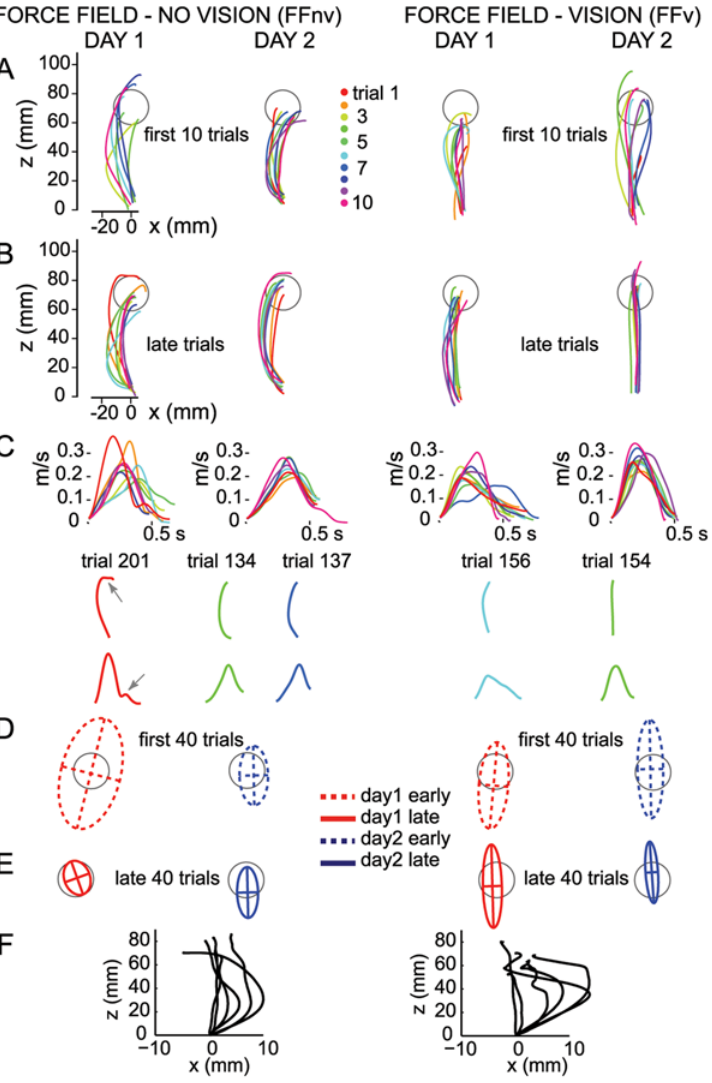
Figure 2. Adaptation to force fields with and without visual feedback: Single subjects. A–B, Day1 and day2 hand paths of two single subjects during the first 10 trials and late trials (ranging from trial 131–220) of force field without visual feedback (FFnv, left) and with (FFv, right). Aborted trials (see methods) are not shown. Hand paths, plotted from detected movement onset to movement end, show displacement from origin to a target at 90 u (gray circle). C, Velocity profiles of the hand paths in the late trials shown in B. Representative single-trial hand paths and their corresponding velocity profiles are also shown. In FFnv, the smooth early phase of the velocity profiles showed that in most cases, the path curvature in the late trials was not due to online corrections. However, in some cases trajectory corrections were observed as reflected in the presence of inflections after peak velocity (gray arrows, trial 201). D–E, Endpoint variability. Shown are 95% confidence ellipses (per subject) for early and late trials of both days. Gray circle shows the size of the target for comparison. F, Aftereffects. Hand paths of subjects in FFnv (n=6) and FFv (n=6) corresponding to the first trial in the learned direction (90 u ) in the post-learning standard block. Starting points of hand paths were aligned at (0,0) for easy comparison of directional deviations. Hand paths were deviated in the direction opposite to that of force field. Since this first trial could occur after several trials in this block, the aftereffect could be smaller. For this reason, aftereffects are used here for illustration only.